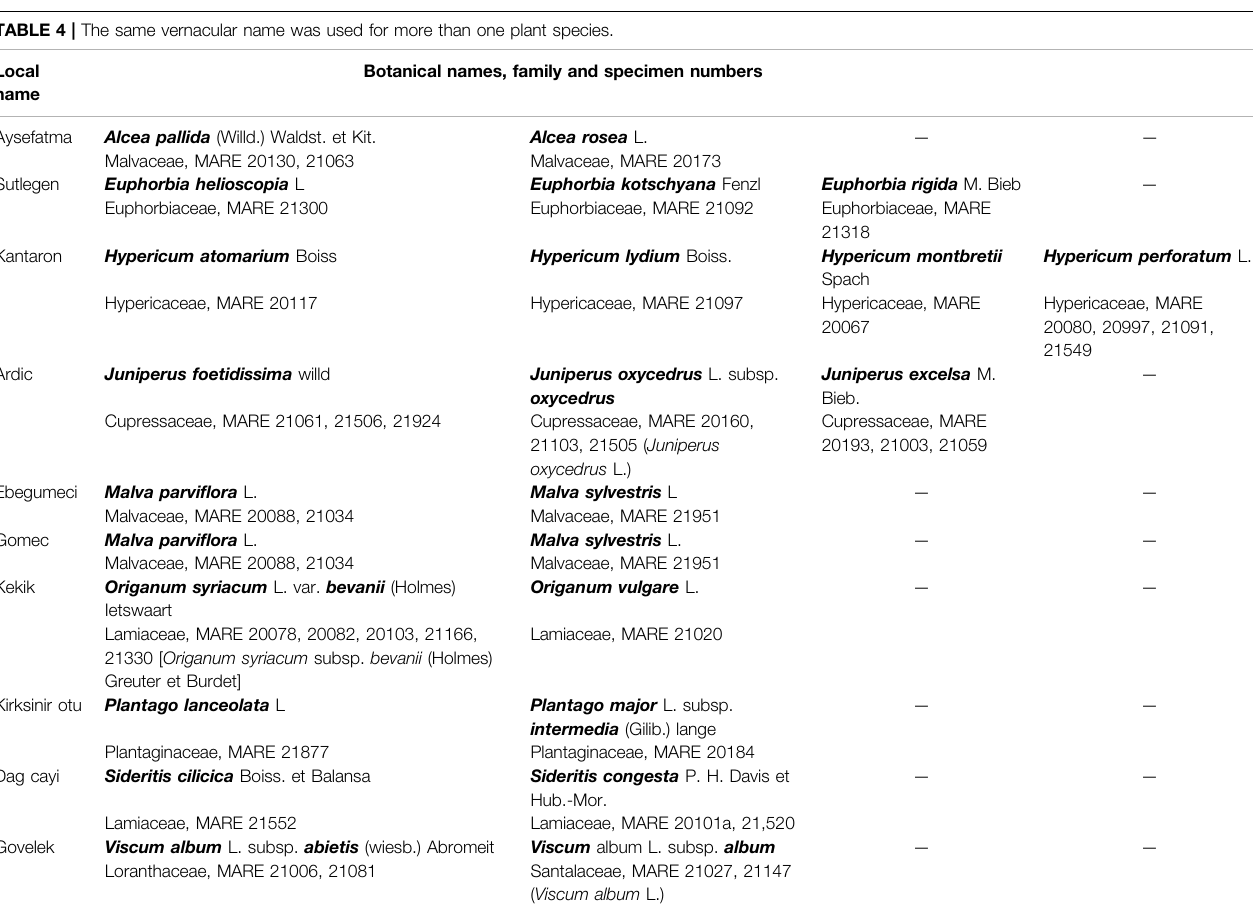
TABLE 4 | The same vernacular name was used for more than one plant